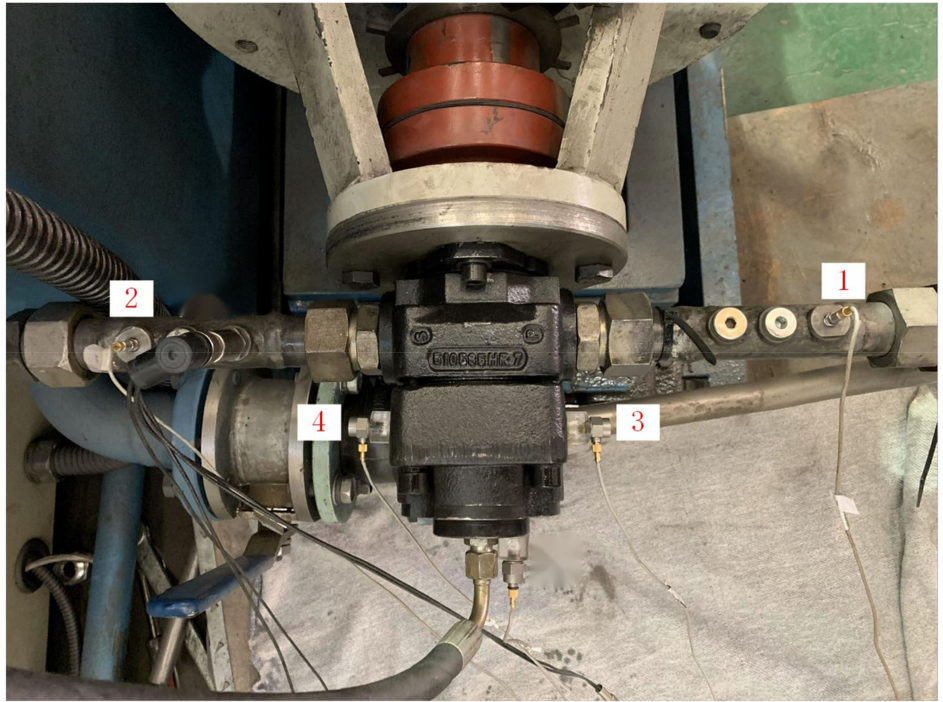
Figure 3. Sensor mounting positions. Four sensors were installed to collect signals: 1. pump inlet pressure pulsation sensor; 2. pump outlet pressure pulsation sensor; 3. pump inlet side acceleration sensor; 4. pump outlet side acceleration sensor.